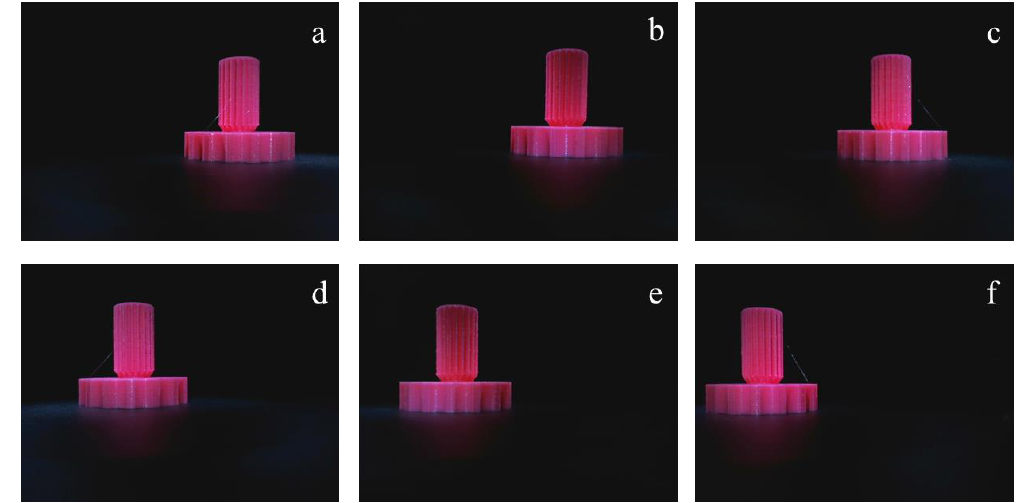
Figure 9. The example of full model of sun gear image results from the first, the second and the third pair of cameras respectively: ( a – c ) the images from the left camera; and ( d – f ) the images from the right camera.